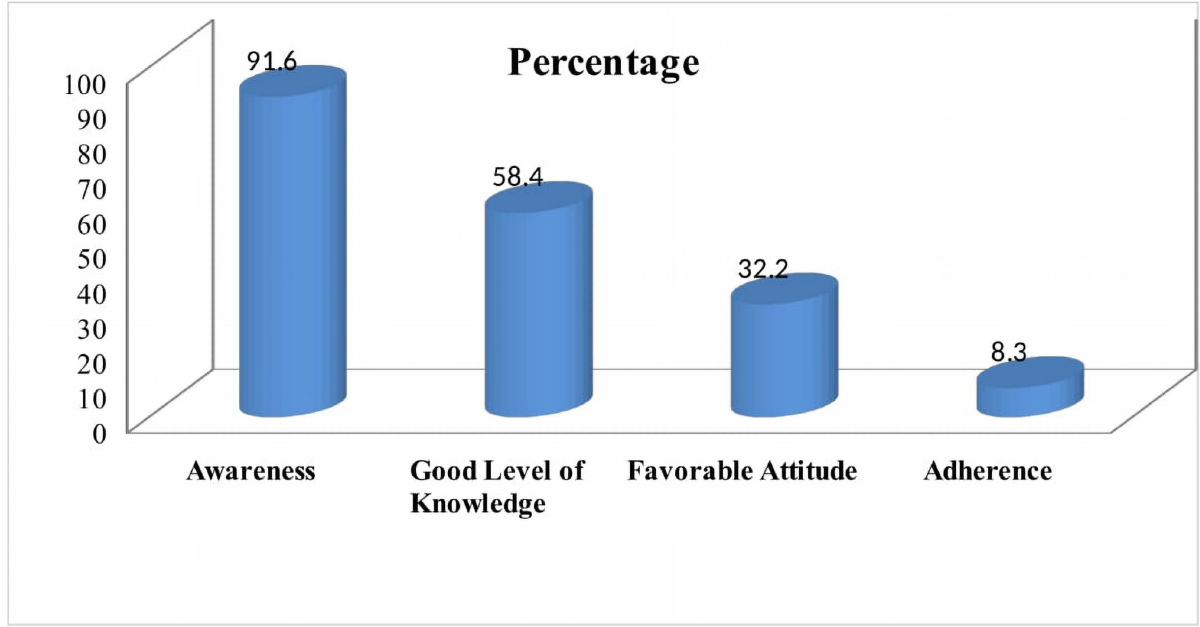
Fig 11. Percentage differences across awareness, knowledge, attitude and adherence to COVID-19 preventive measures, Oromia region, Ethiopia, September 2020 to March 2021.